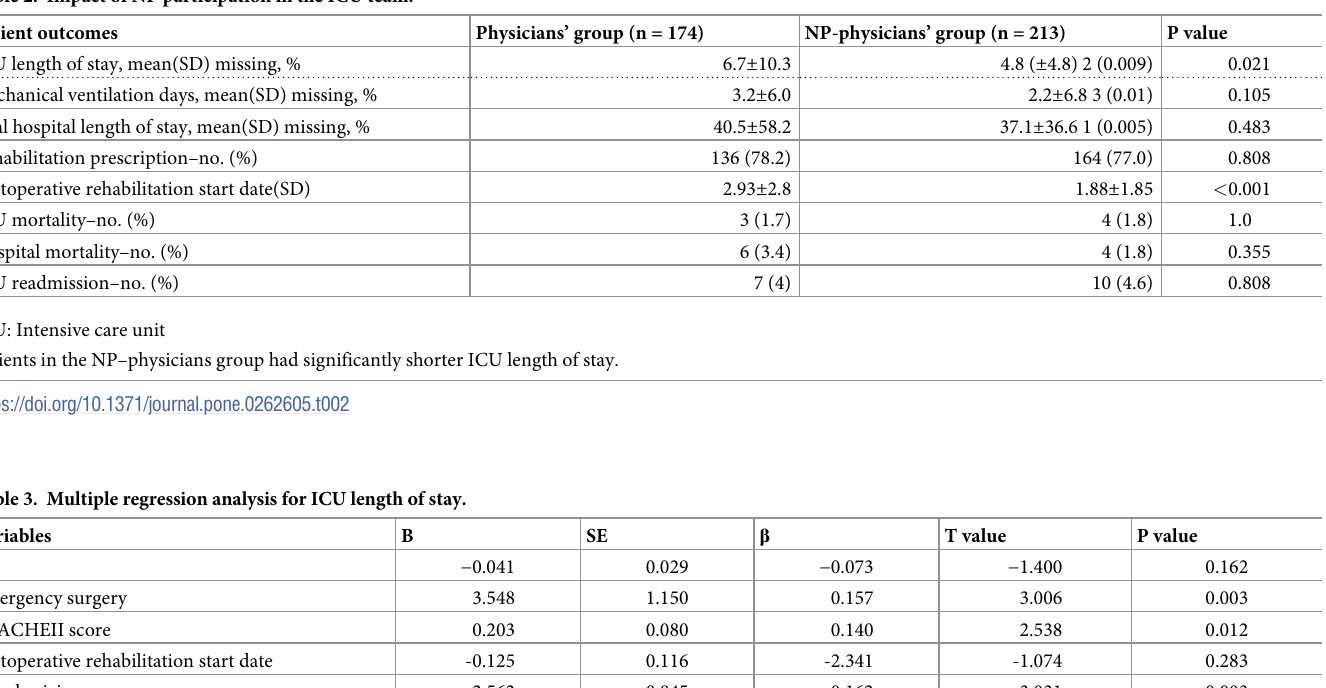
Table 2. Impact of NP participation in the ICU team.